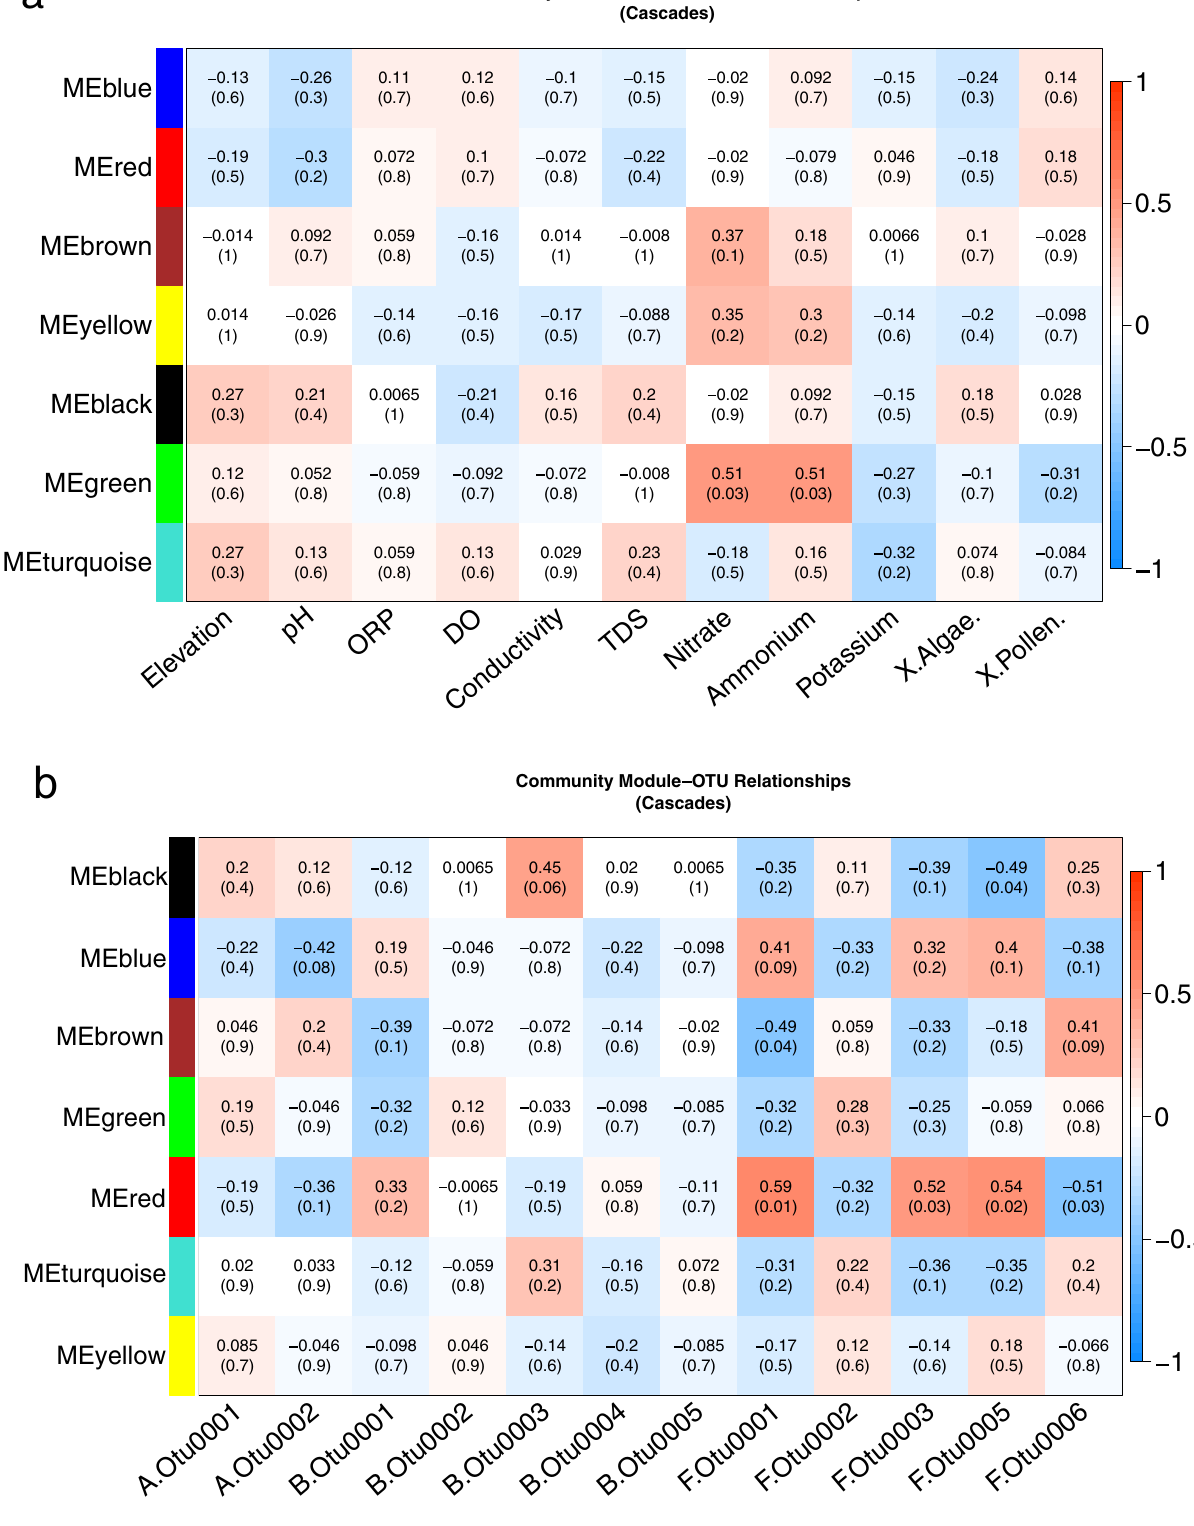
Figure 3. (a, b) Heat map showing snow community modules in the Cascades with ( a ) module- environment and ( b ) module-OTU correlations (Kendall-Tau). OTUs of interest were user selected and highly abundant. The upper value in each individual square is the correlation coefficient (with p-values parenthetical). Modules of the same color in different regions are not necessarily comprised of the same